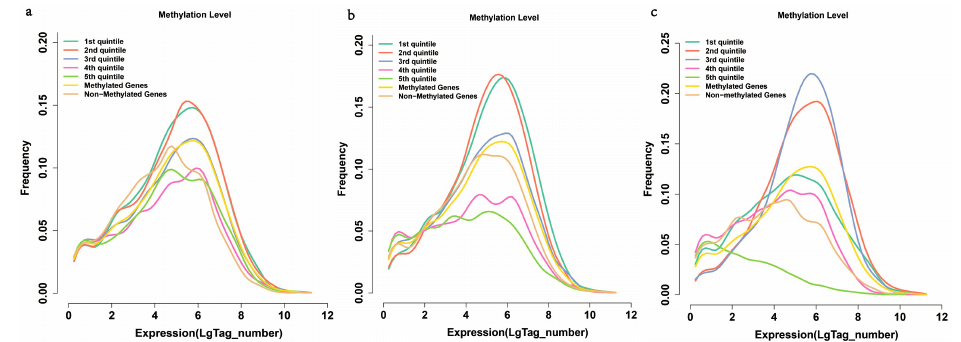
Figure 7. Correlation between DNA methylation and expression levels of